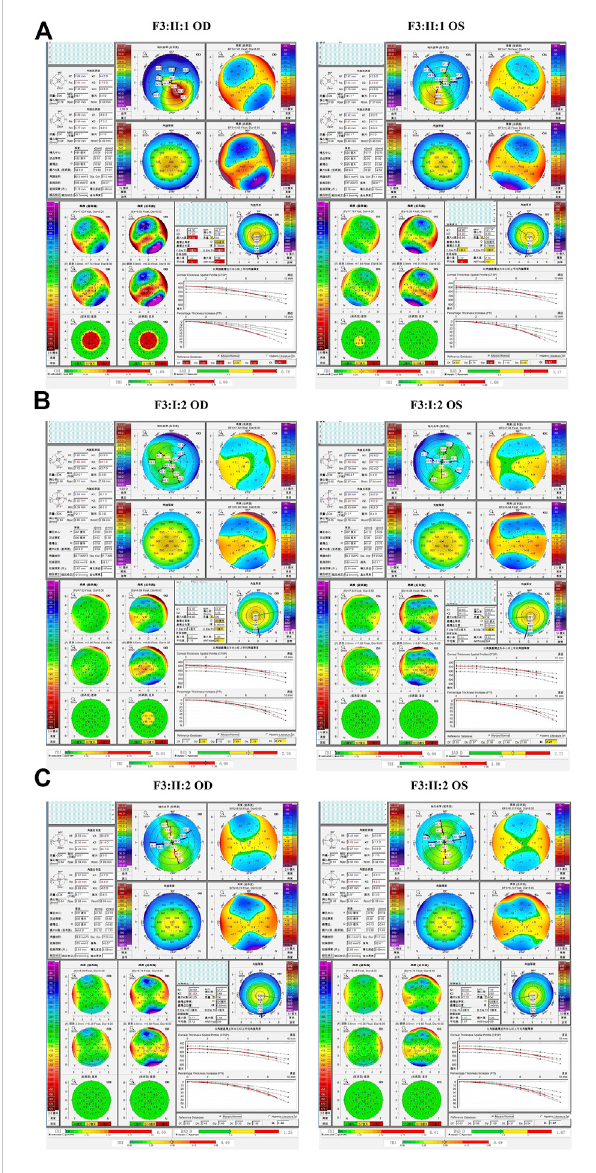
FIGURE 6 Pentacam and Corvis ST images of the proband and asymptomatic fi rst-degree relatives carrying the p.L17V variant in F3. (A) Abnormal corneal topography and biomechanics of the proband. (B) The mother with variant was found to have eight suspicious parameters TP, ARTmax, B.Ele.Th, Db, Dt, Da, BAD-D, and TBI in the right eye, while three suspicious parameters B.Ele.Th, BAD-D and TBI in the left eye. (C) The brother with variant was identi fi ed to have one suspicious parameters TBI in both